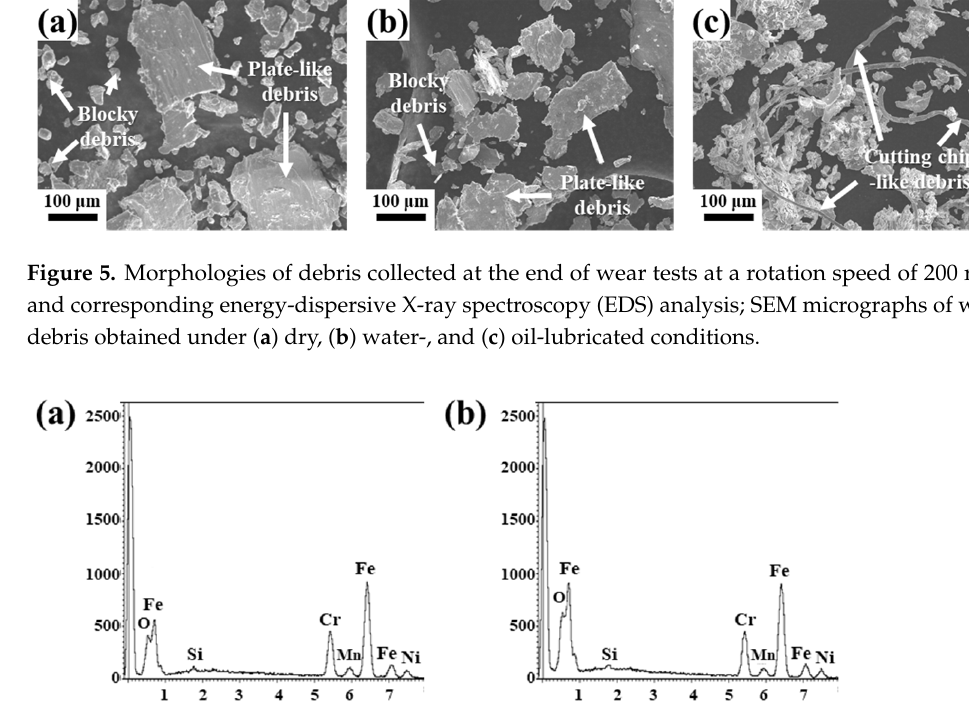
causes much milder abrasive wear, as well as a decrease in the adhesive and fatigue wear.